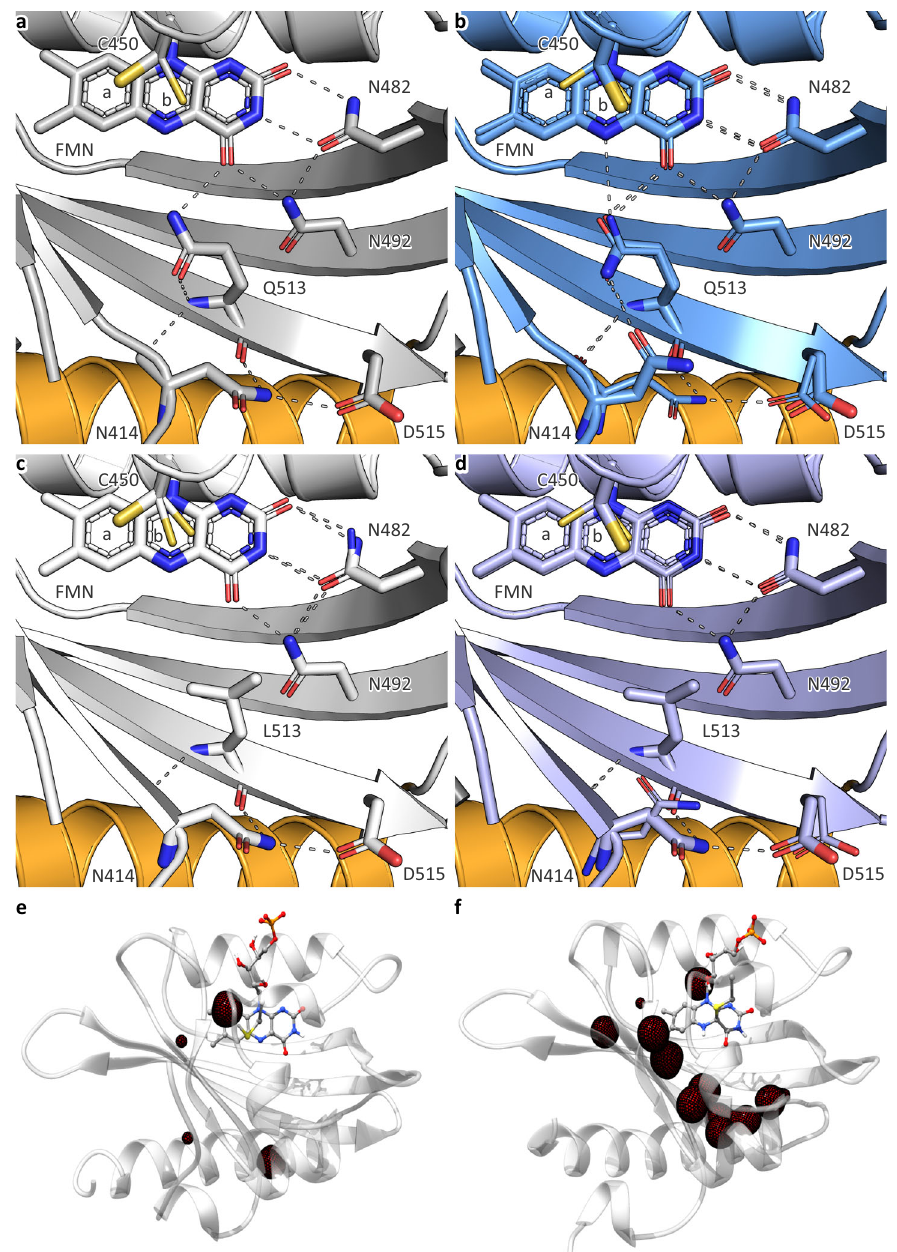
Fig. 5 Structural analyses of As LOV2 variants. a Chromophore-binding pocket of wild-type As LOV2 in its dark-adapted state as revealed by a 1.00 Å crystal structure. b Chromophore-binding pocket of wild-type As LOV2 in its light-adapted state as revealed by a 1.09 Å crystal structure. c Chromophore- binding pocket of As LOV2 Q513L in its dark-adapted state as revealed by a 0.90 Å crystal structure. d Chromophore-binding pocket of As LOV2 Q513L in its light-adapted state as revealed by a 0.98 Å crystal structure. For clarity, helices C α and D α are not shown in panels a-d. The J α helix is drawn in orange, and the fl avin- mononucleotide cofactor and key amino acids are highlighted in stick representation. Minor conformations of residues and the fl avin nucleotide are drawn in narrower diameter. The active-site cysteine 450 adopts two principal orientations, denoted ‘ a ’ and ‘ b ’ . In the structures of dark-adapted As LOV2 wild-type, dark-adapted Q513L, and light-adapted Q513L, orientation ‘ b ’ splits into two subpopulations with slightly different χ 1 angles. Dashed lines denote hydrogen bonds. e Water density in the interior of dark-adapted As LOV2 Q513L derived from a 300 ns classical molecular dynamics simulation. The red mesh denotes a density level of 0.3 water molecules per Å 3 . f As e but for light-adapted As LOV2 Q513L. Corresponding simulations for As LOV2 wild-type are provided in Suppl. Fig. 13a,